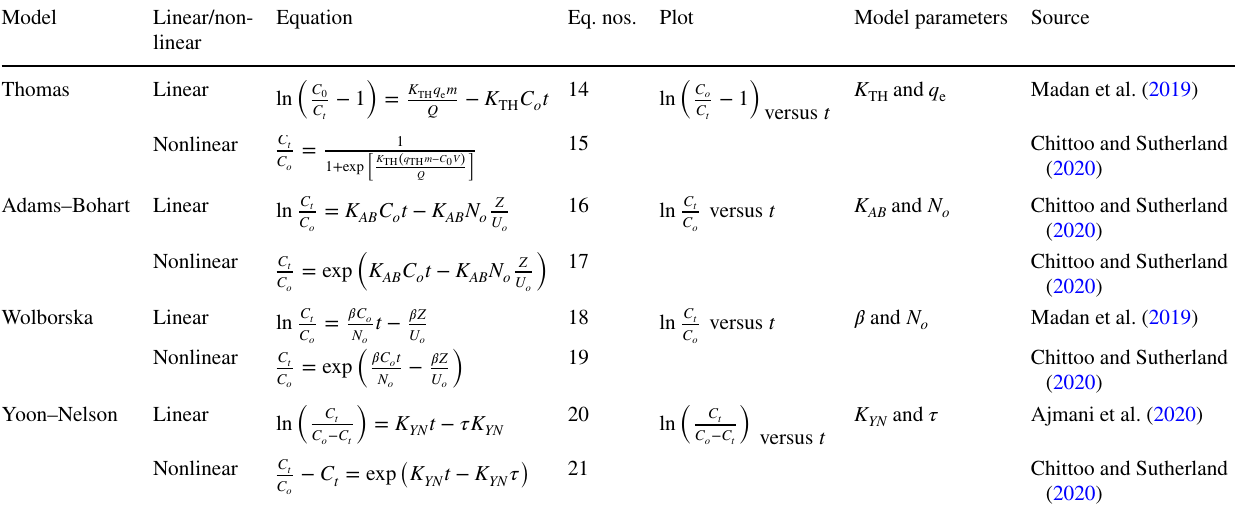
Table 1 Linear column kinetic model equations Model Linear/non- Equation Eq. nos. linear